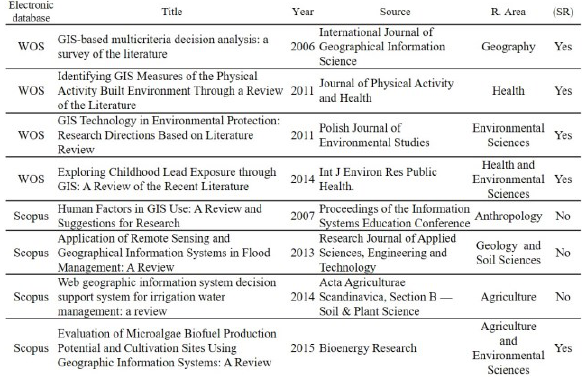
Table 1: Relation of publications which deal with the review of the GIS literature and its